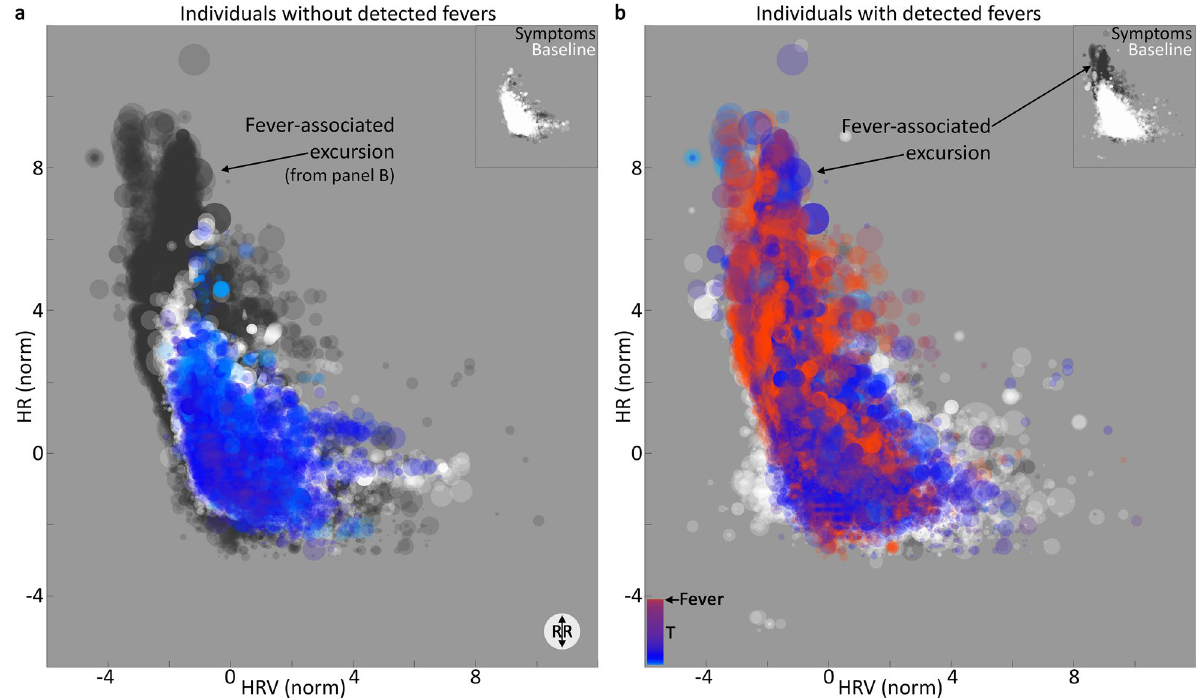
Figure 2. Elevated temperature is clearly detectable, but only loosely correlated to changes in HR, HRV, and RR. All time points for all individuals with original (not interpolated) measurements from temperature (T), heart rate (HR), HR variability (HRV), and respiration rate (RR) sorted into those not showing fever-like days during their reported symptom window ( a ) and those showing fever-like days during their reported symptom windows ( b ). Baseline points: white. Symptom windows: color (bar in lower left, b , proportional to T, max set to threshold of digital biomarker for nighttime fever detection). Dark background points: symptom window from opposite group for comparison. Dot size proportional to RR. Insets: symptom window (dark) and baseline (white) points for that panel. NB: despite being normalized by the mean of baseline day min and max values as described for temperature (see “Methods”), HR and HRV show wide ranges, reflecting large day-to-day variance within individuals. Larger and redder spots are more apparent in the “fever-associated excursion” but